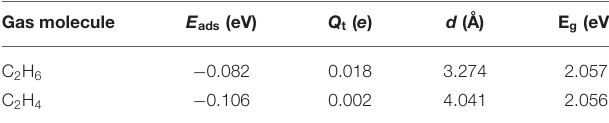
TABLE 2 | The parameters of MoS 2 monolayer adsorption